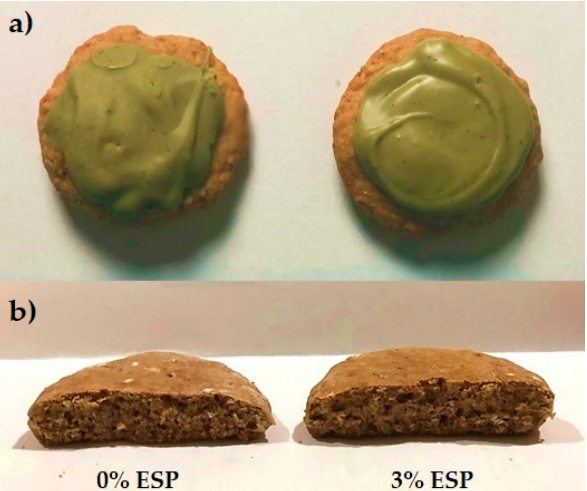
Figure 1. Process flow diagram of gingerbread production.